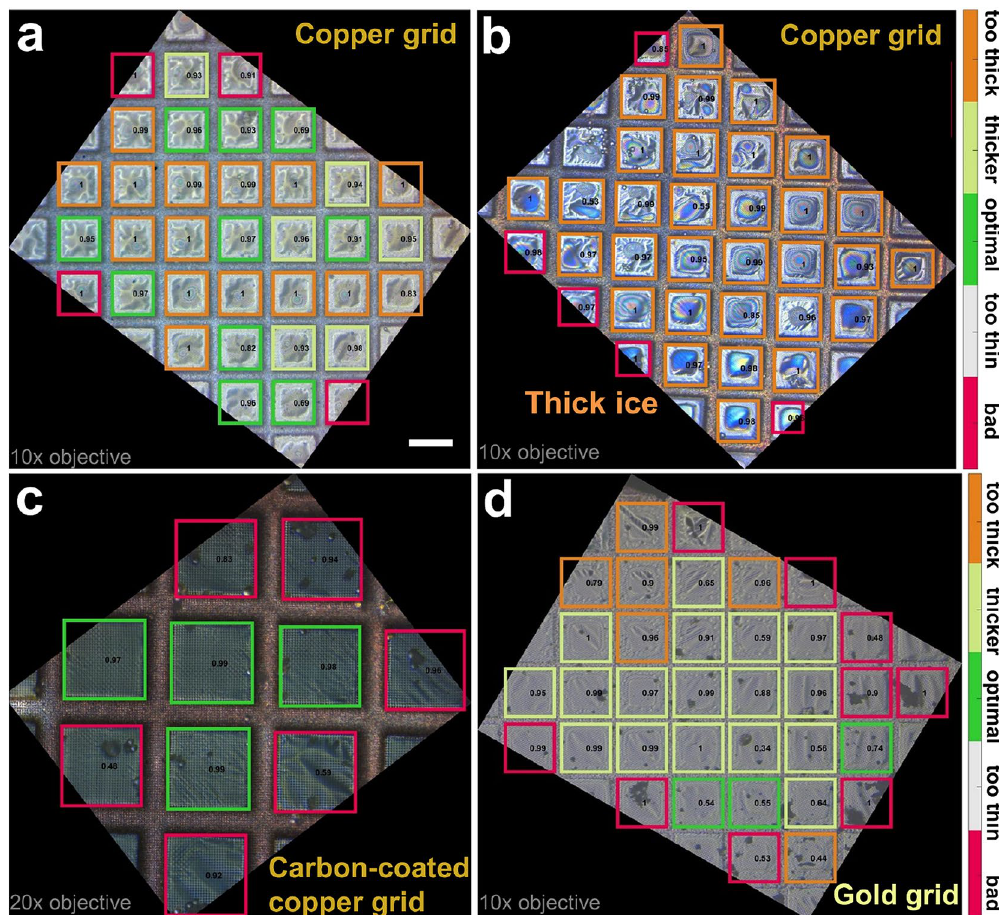
Figure 4. Application to EM grids coated with samples. Examples after having applied our method for copper ( a,b ), carbon-coated copper ( c ), and gold ( d ) grids. While ( a , b , c ) were imaged using a 10 × magnification objective, ( c ) was measured at higher resolution using a 20 × objective. The individual grid squares are highlighted with colours according to the ice layer quality defined in this work by 5 classes: bad (class 0, in red), too thin (class 1, in white), optimal (class 2, in green), thicker (class 3, in bright green) and too thick (class 4, in red), respectively (colour legends indicated on the right). While the grids shown in ( a) and ( c ) exhibit a nearly ideal ice behaviour for most of its grid squares (indicated by numerous green and bright-green classified grid squares; the squares in red in ( c ) were only partially imaged), the grid in ( b ) shows only regions with thicker ice (in orange), and the one displayed in ( d ) is an intermediate case with a mixture of class 2 and class 3 grid squares. Numbers indicate confidence of ANN. Scale bar 50